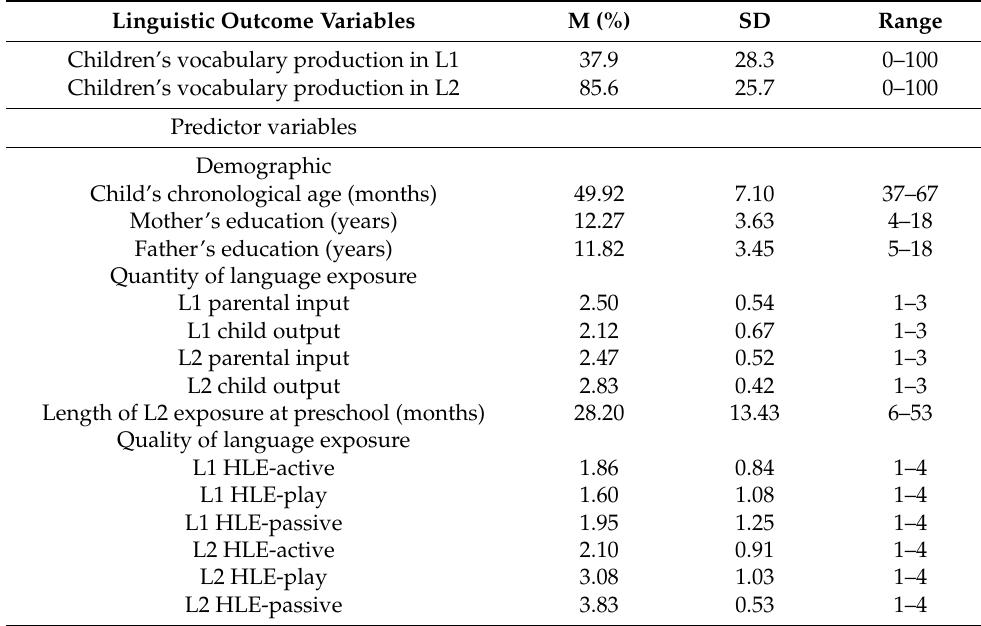
Table 1. Descriptive data (mean; percentage; standard deviation and range) of linguistic outcome variables (children’s vocabulary production in L1 and L2) and predictor variables (demographic, quantity of linguistic exposure, and quality of linguistic